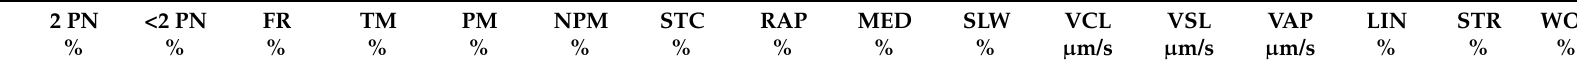
Table 9. Pearson correlation coefficient for boar sperm traits (sperm motility and velocity traits) and the oocyte fertilization (pronucleus)